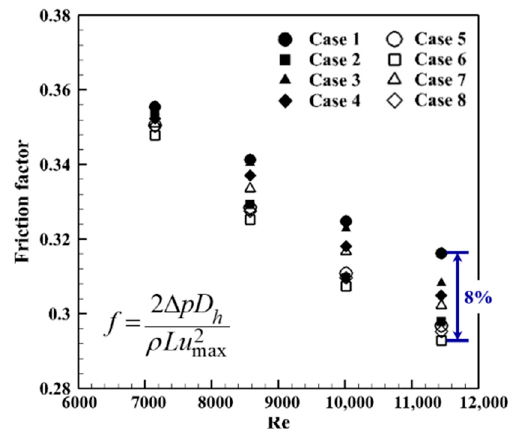
Figure 11. Friction factor concerning the Reynolds number.